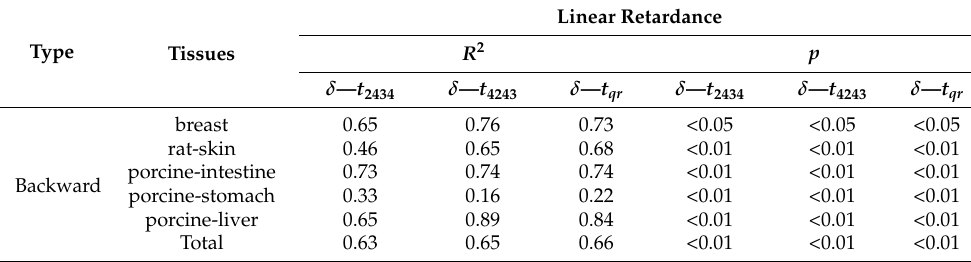
Table 5. Correlation and statistical analysis comparison results between backscattering measured MMT and MMPD linear retardance parameters for each kind of bulk tissue